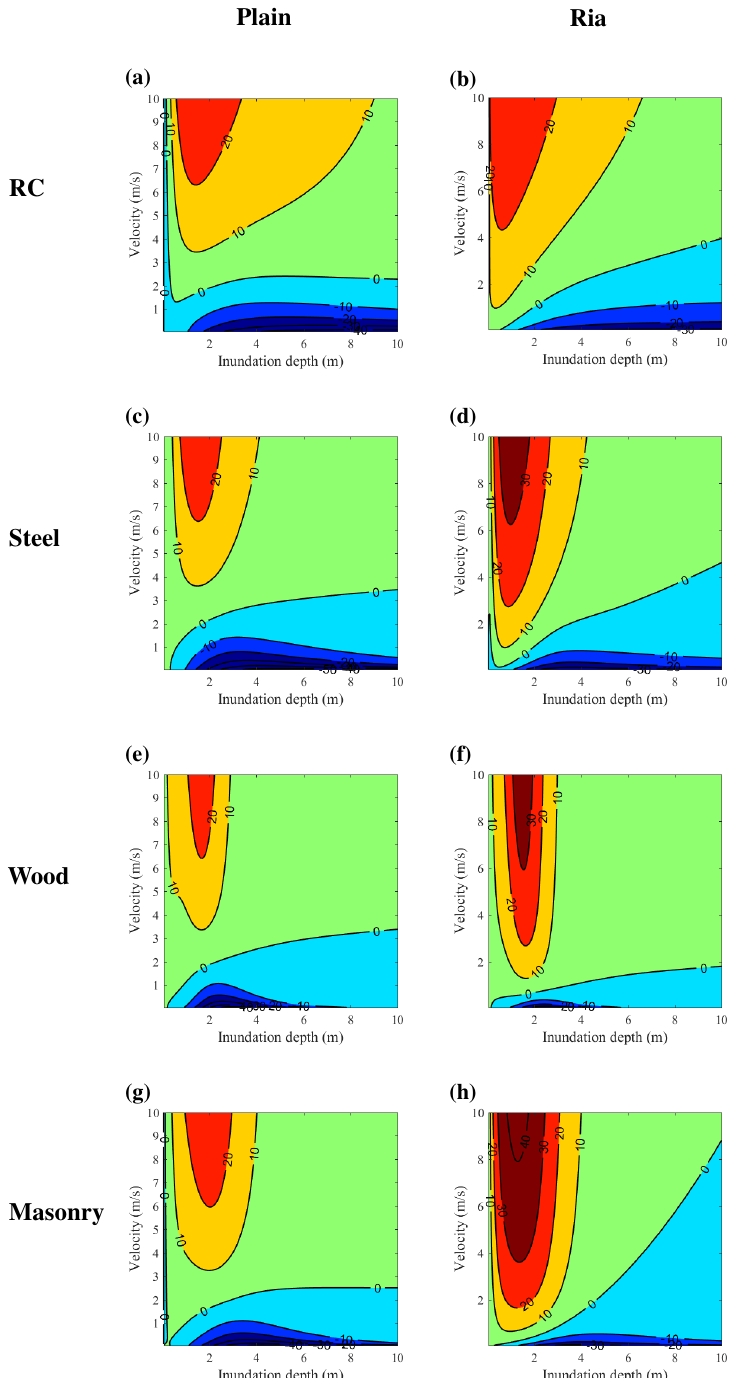
Figure 4. Percentage of loss difference considering and neglecting velocity: ( a , b ) RC; ( c , d ) steel; ( e , f ) wood; and ( g , h ) masonry; on the left for plain coast and on the right for ria